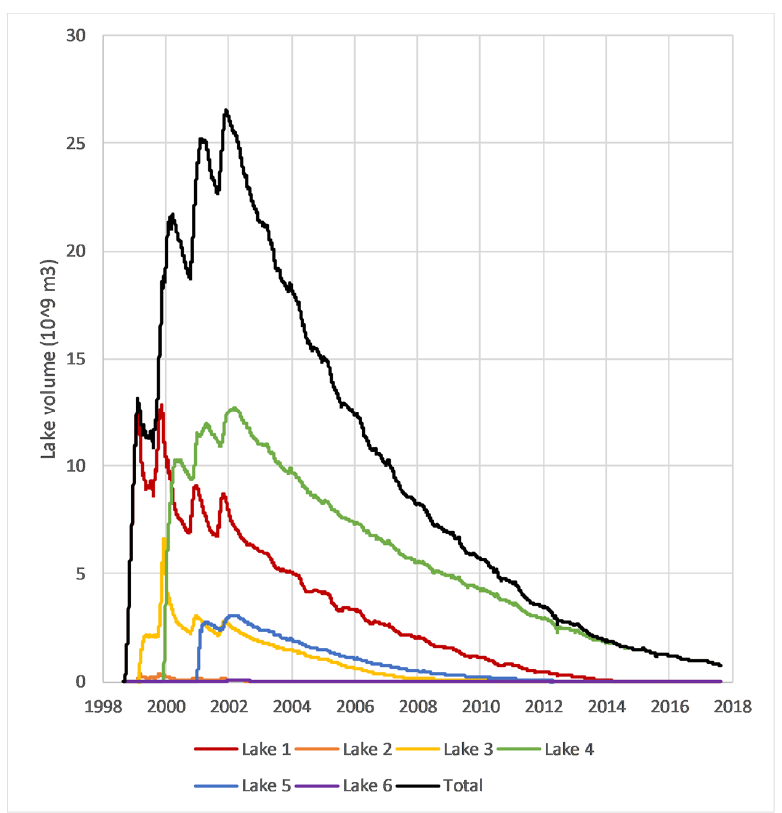
Figure 11. Hypsographic curves for each lake, relating lake area to depth (from AST14 DEMs).